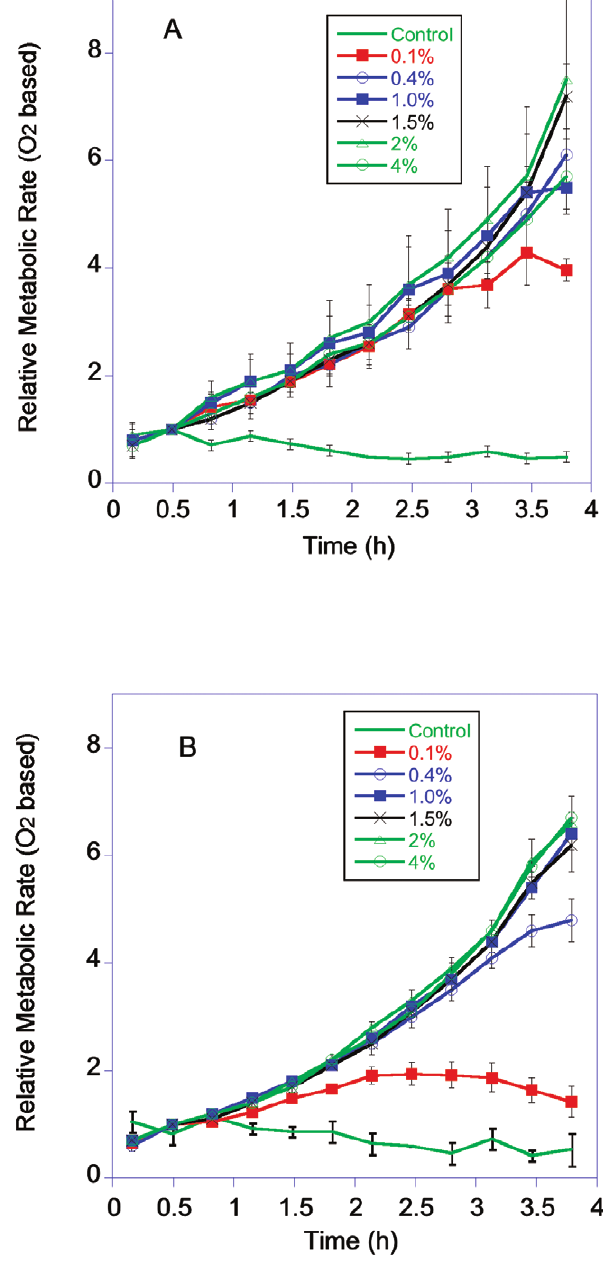
Figure 4. Relative metabolic rate of BY (4A) and RM (4B) grown in YP with a starting concentration of 0.1 to 4% dextrose based on O 2 consumption.